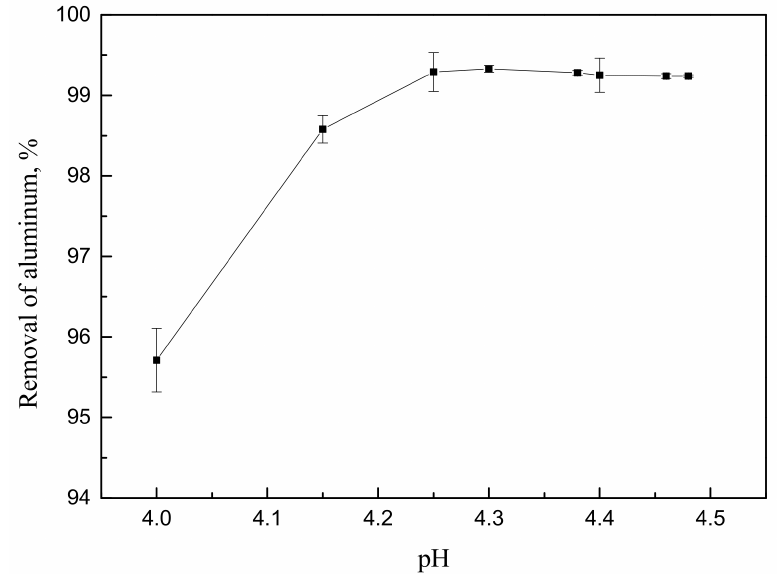
Figure 1. Effect of the pH value on the removal of